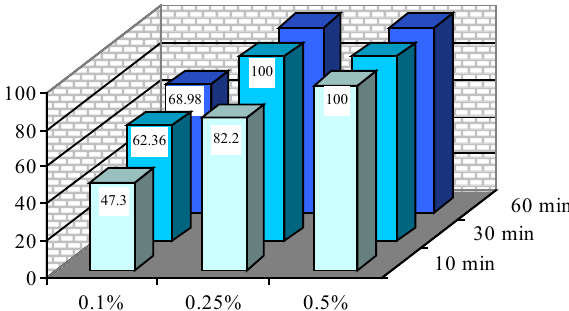
Fig. 1. Ovocidal efficiency (%) of “Virosan” against eggs of Passalurus